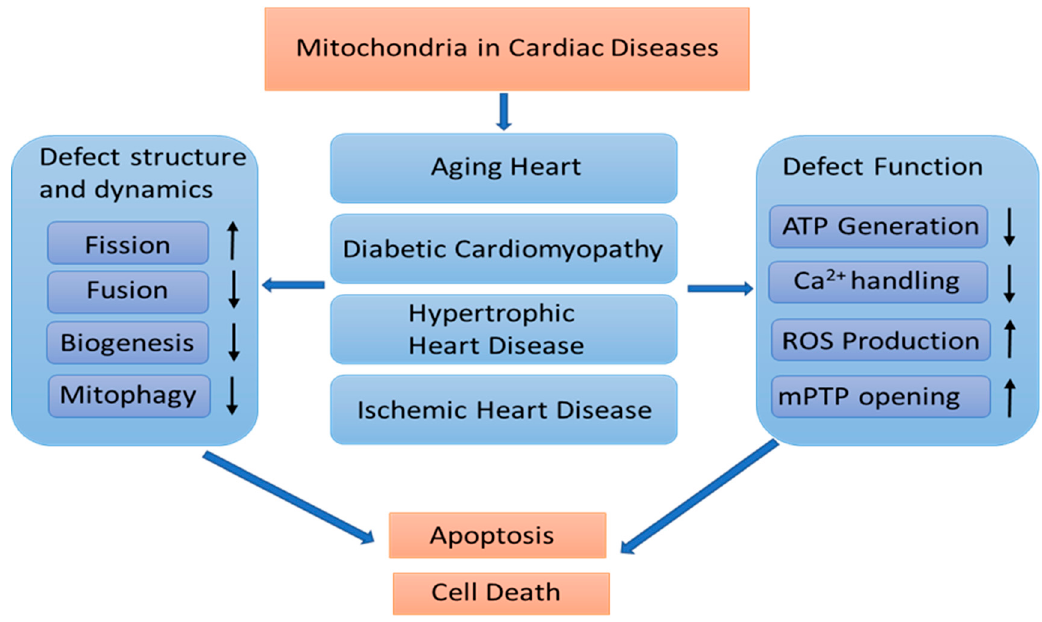
Figure 4. Overview of mitochondrial remodeling in cardiac diseases. In cardiac diseases, both mitochondrial structural and functional remodeling are changed, resulting in impaired mitochondrial function, leading to a declined ATP production, and ROS accumulation and mPTP opening, finally causing apoptosis and cell death. ROS: reactive oxygen species. mPTP: mitochondrial permeability transition pore.